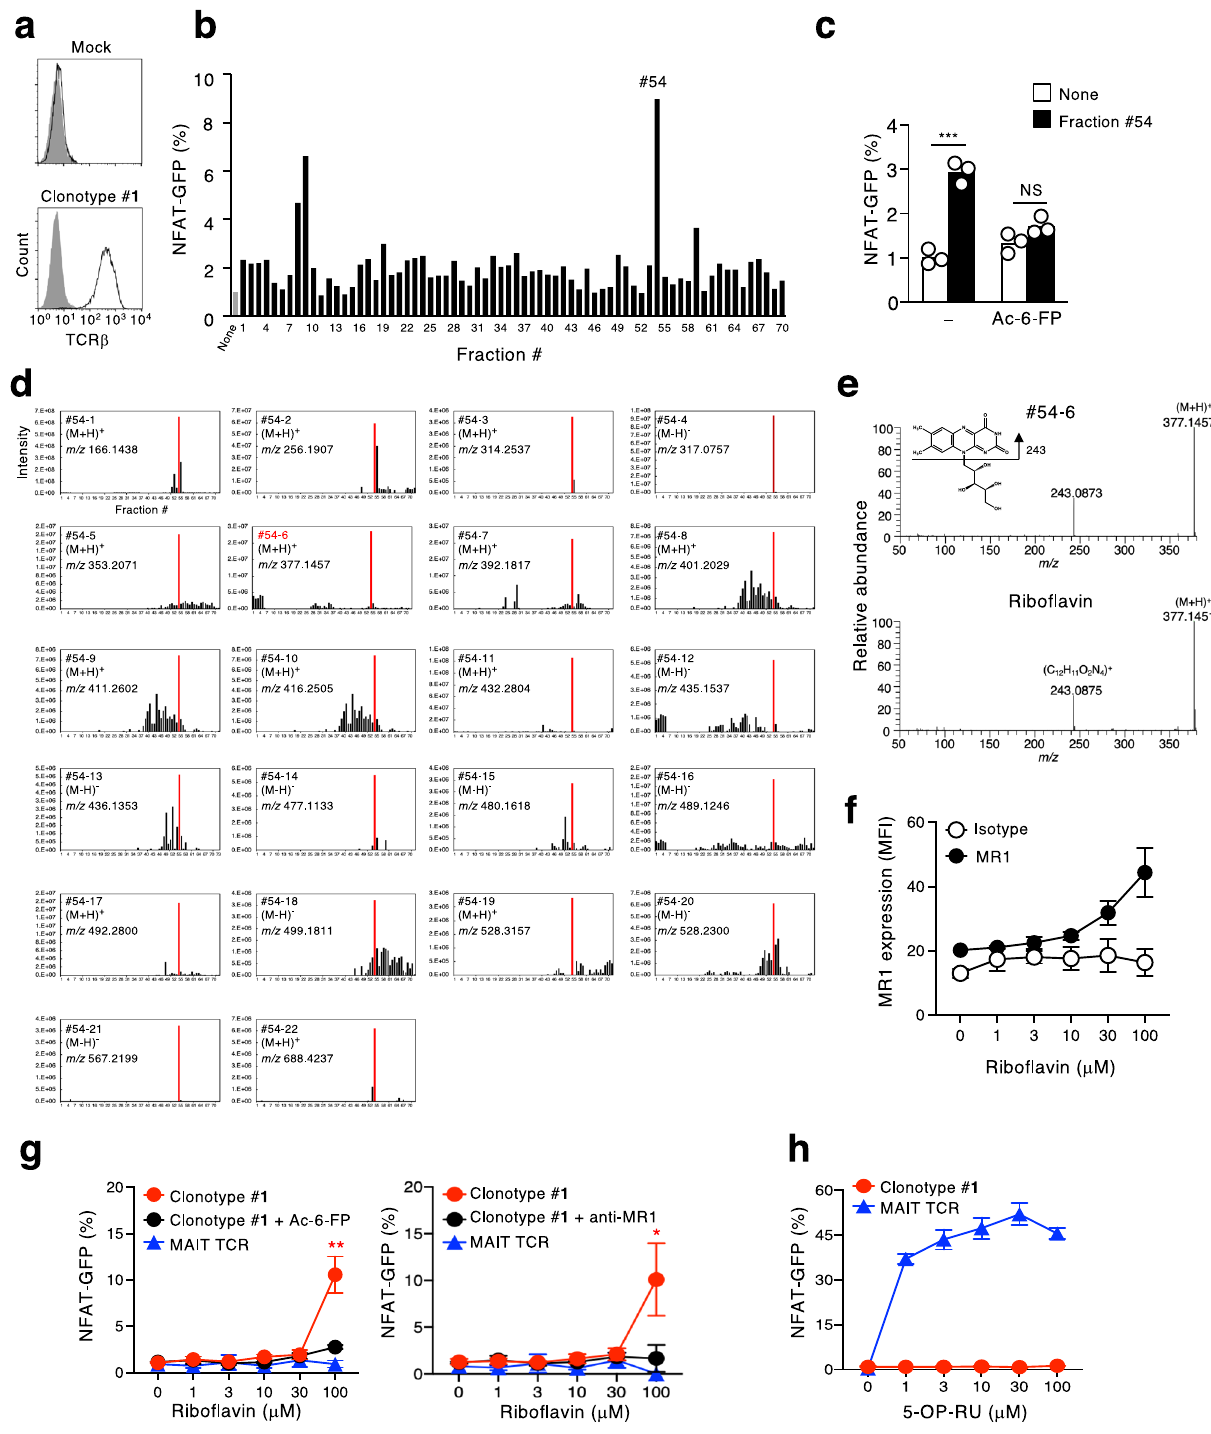
Fig. 6 | Clonotype # 1 recognizes ribo fl avin in an MR1-dependent manner. a Histograms show clonotype # 1 TCR expression as compared with the parental cell line (Mock). These cells were stained with isotype control (closed) and anti- TCR β antibody(open). b , c GraphshowsNFAT-GFPexpressionsinthereportercell line expressing clonotype # 1 TCR after cocultured with fractionated fecal homo- genates in the presence of mouse MR1-expressing NIH3T3 cells. c Ac-6-FP (10 μ M) was used to block interactions between MR1 and TCR. *** p =0.0004 by unpaired two-tailedStudent ’ s t -test.NSindicatesnotsigni fi cantlydifferent. d Plotsoftheion intensity of precursor ions contained in the fraction of #54. #54-6, having similar m/z valuetoexactmassofknownmetabolitesinthehumanmetabolomedatabase, was highlighted in red. e HRMS/MS spectra of ribo fl avin; fraction #54-6 (upper) andauthenticstandard(lower)inthepositiveionmode. f MR1expressionsonMR1-